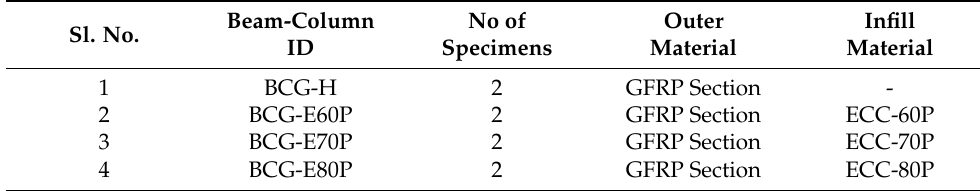
Table 7. Details of the GFRP beam-column